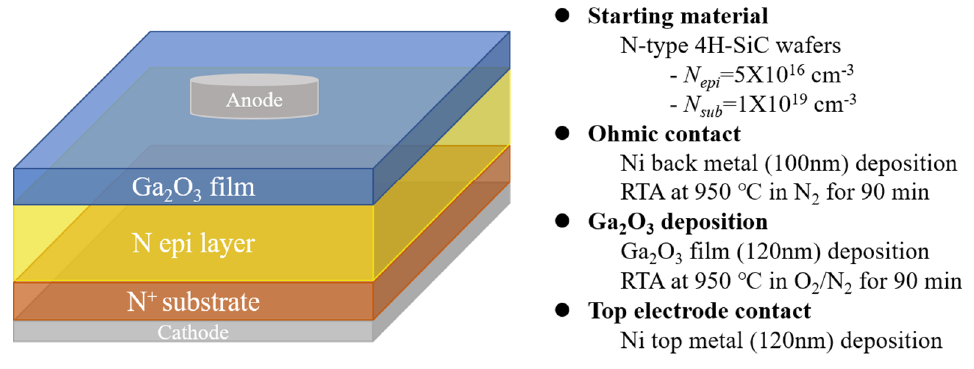
Figure 1. Structure of Ga 2 O 3 /4H-SiC heterojunction diode and fabrication flow.